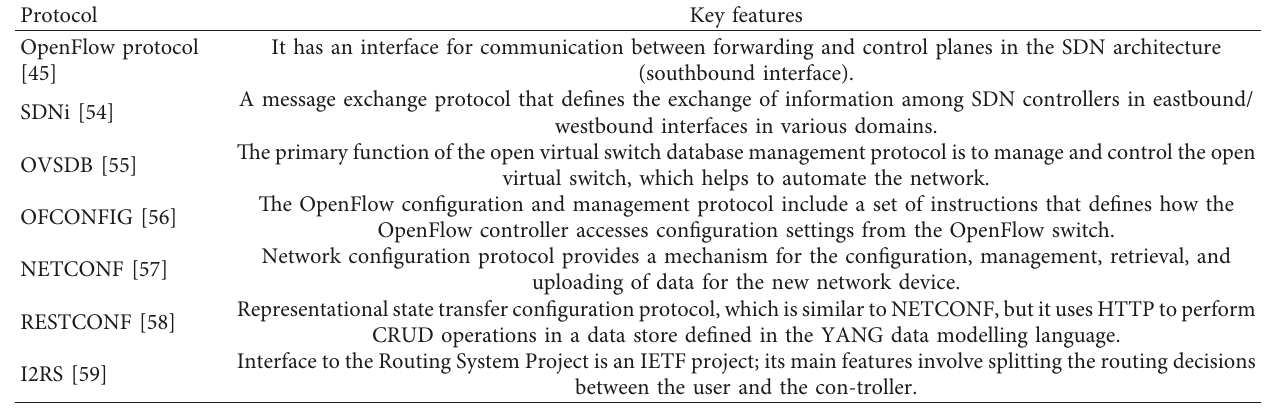
Table 1: Other SDN-related